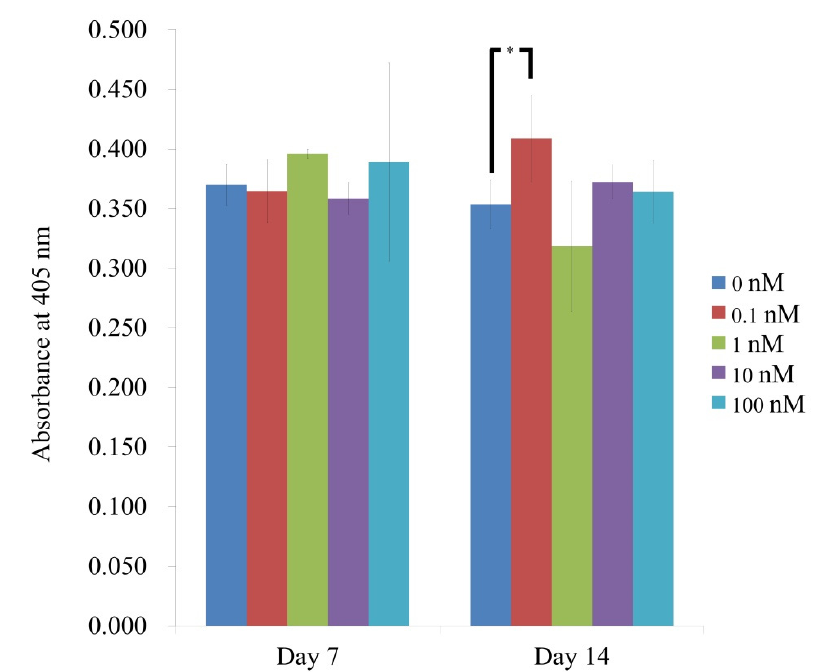
Figure 4. Graphical representation of alkaline phosphatase activity results on days 7 and 14. * p < 0.05 vs. time-matched 0 nM group. * p < 0.05 vs. time-matched 0 nM